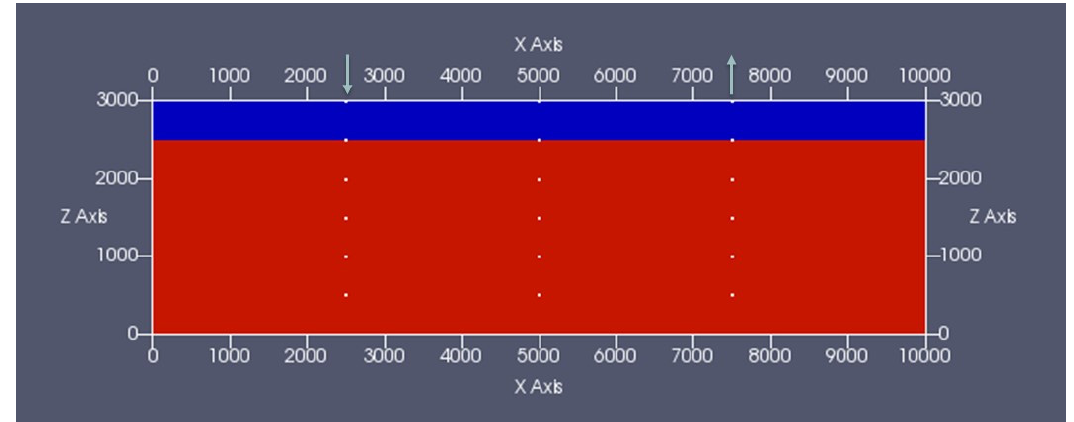
Figure 2. Regional-Scale Model Domain and Initial Salinity Stratification cells used by Park et al. [24]) [Blue = initially fresh water ( ρ o ≈ 1.00 g / cm 3 ) / Red = initially brine ( ρ bo ≈ 1.20 g / cm 3 )]. Initial pressure was calculated as a fresh water hydrostatic gradient. Initial tracer concentration (Ct), representing salinity, was stratified, with fresh water (Ct = 0.029 M, corresponding to ρ o